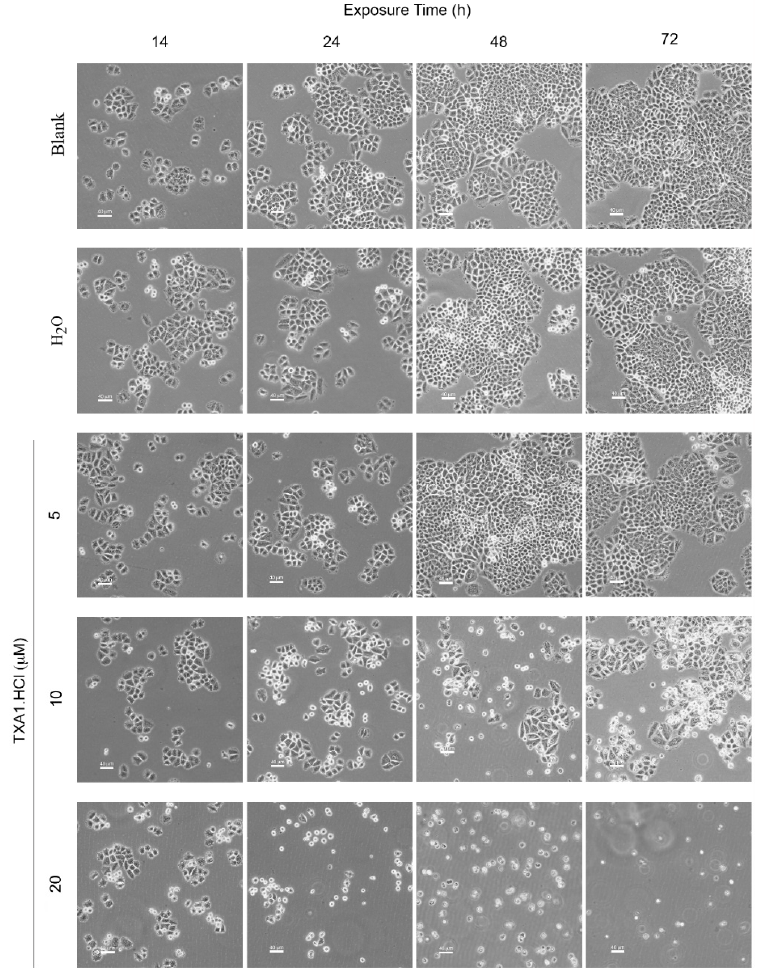
Figure 4. Effect of TXA1·HCl treatment in MCF-7 cells, analyzed by phase contrast microscopy. Cells were treated for 14, 24, 48 and 72 h with medium only (Blank), H 2 O and TXA1·HCl (5, 10 and 20 µM). Images are representative of at least three independent experiments. Scale bar = 40 µm.